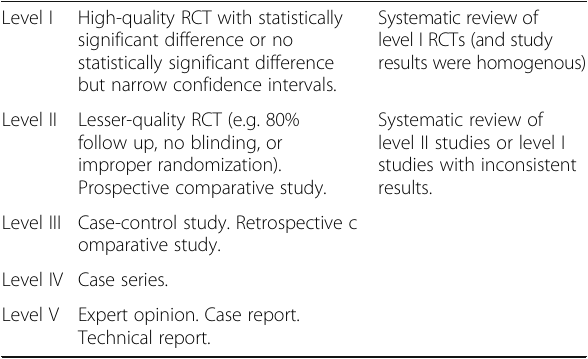
Table 1 Levels of evidence for primary research question on therapeutic studies Level I High-quality RCT with statistically significant difference or no statistically significant difference but narrow confidence intervals. improper randomization). Prospective comparative study.